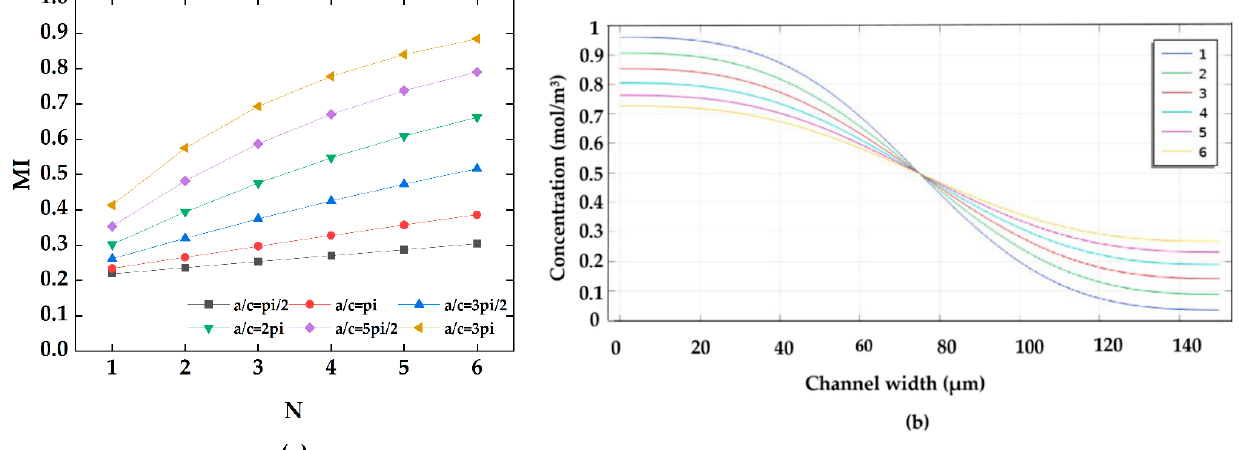
Figure 5. Variations of the mixing quality at the outlet with different mixing units: ( a ) the mixing index of different amplitude to wavelength ratios, ( b ) the mixing concentration at the outlet.